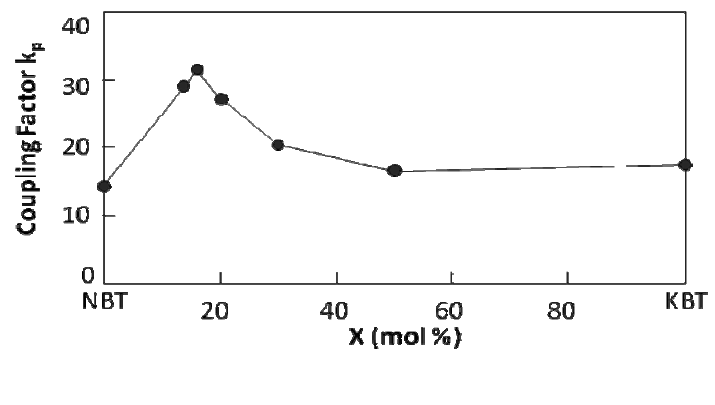
to 192 pC/N [55]. Figure 7. Electromechanical coupling factor of [Bi KBT concentration (x), reproduced from Sasaki et al.